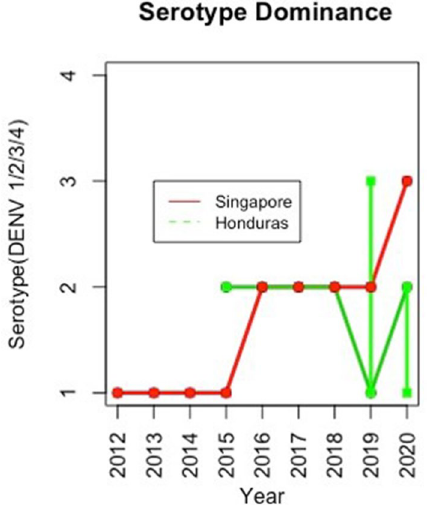
Figure 8. Graph showing the serotype-dominance through 2012–2020 (Singapore) and 2015–2020 (Honduras) representing the circulation of different dengue virus